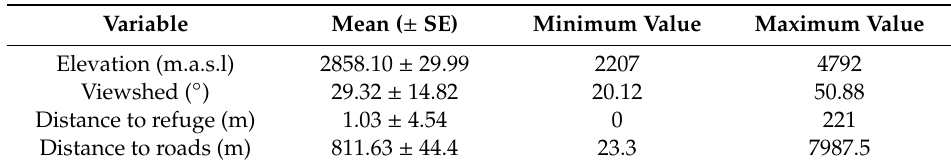
Table 2. Summary statistics for significant continuous variables (main e ff ects and interactions) remaining in the final model predicting flight initiation distance (FID) in golden marmot ( Marmota caudata aurea ) colonies.